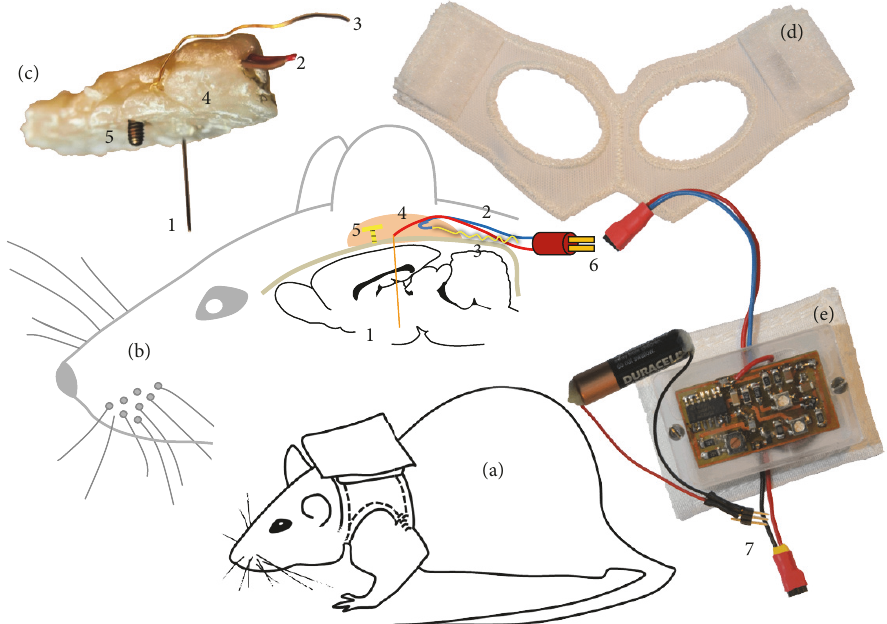
Figure 2: Schematic views of the unipolar DBS rat model. (a) Rat with stimulator in backpack; (b) sagittal view illustrating the locations of the implanted unipolar DBS electrode; (c) image of an explanted DBS mounting; (d) backpack vest with Velcro hooks; (e) stimulator in PMMA housing with pocket and current-pulse battery. 1: unipolar Pt/Ir electrode; 2: electrode cables; 3: gold-wire counter electrode; 4: biocompatible dental acrylic embedding all components; 5: anchor screw to fix the acrylic mounting to the skull; 6: electrode connector; 7: current-pulse battery connector.